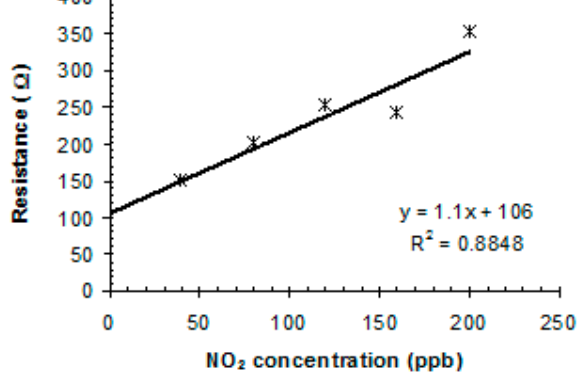
Figure 9. Linear fitting of sensor response toward ppb-level of NO 2 gas.